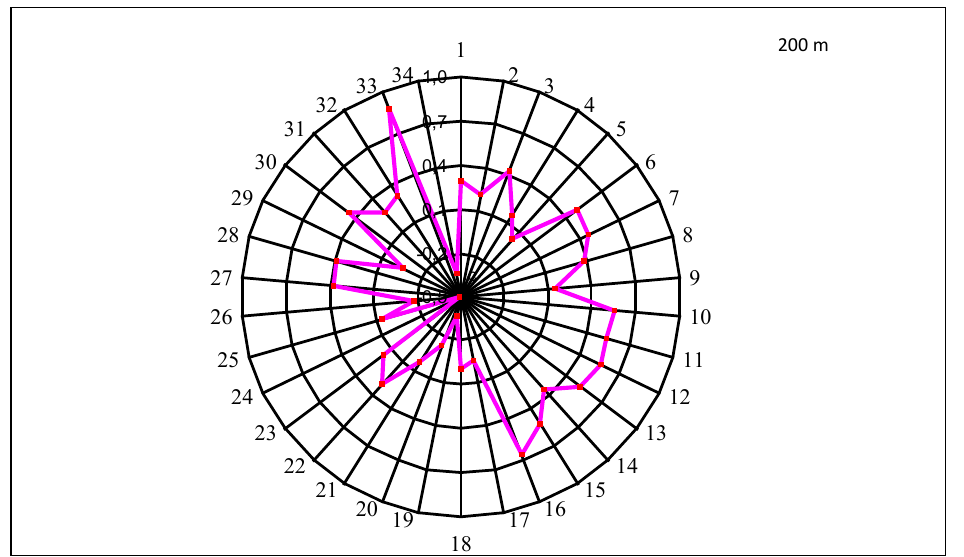
Fig. 4. Correlation of elite sportsmen’s morphological functional indicators with results of 200 meters’ breaststroke: